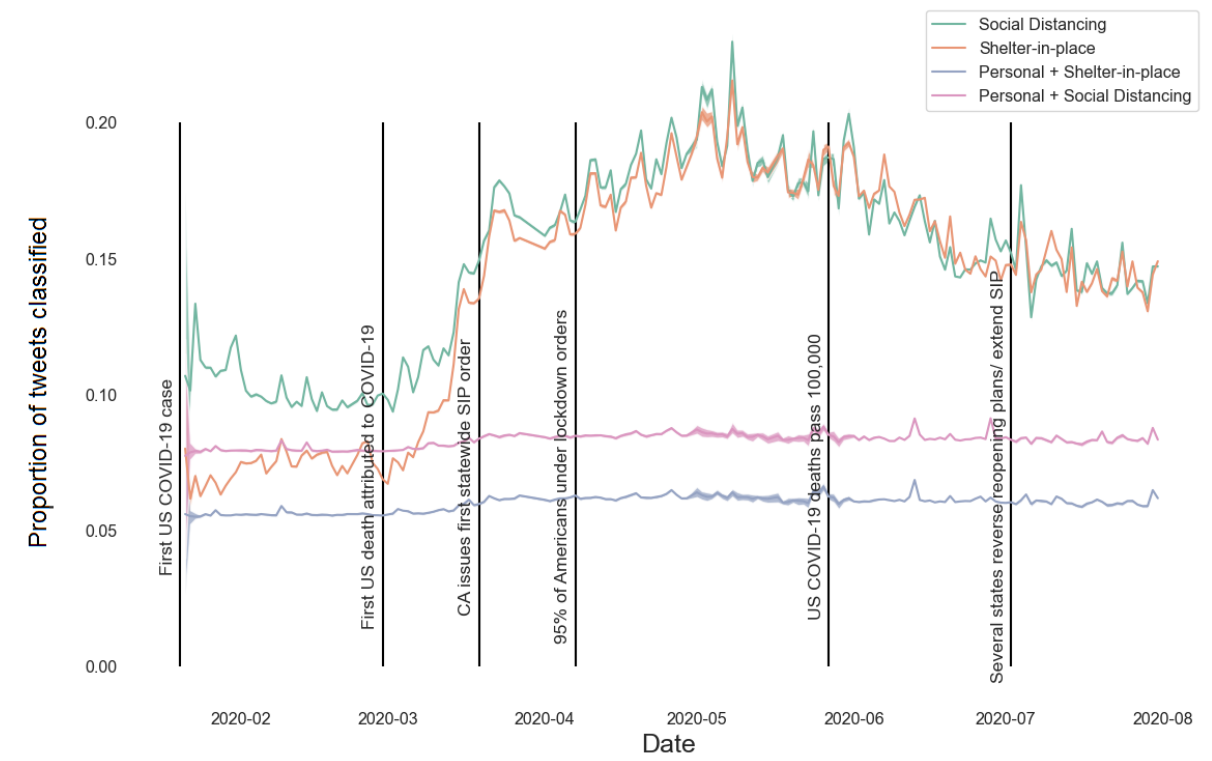
Figure 3. Temporal patterns in social distancing and shelter-in-place tweets. The proportion of tweets classified as general social distancing, shelter-in-place, personal shelter-in-place, and personal social distancing are shown by date. Relevant events in the outbreak are shown as vertical lines. As states increased shelter-in-place and lockdown orders, the number of tweets about social distancing and sheltering-in-place dramatically increased. Shading shows the 95% CI calculated using classifier-adjusted bootstrapped sampling while the median is a solid line. CIs are extremely small at several time points. CA: California; SIP: